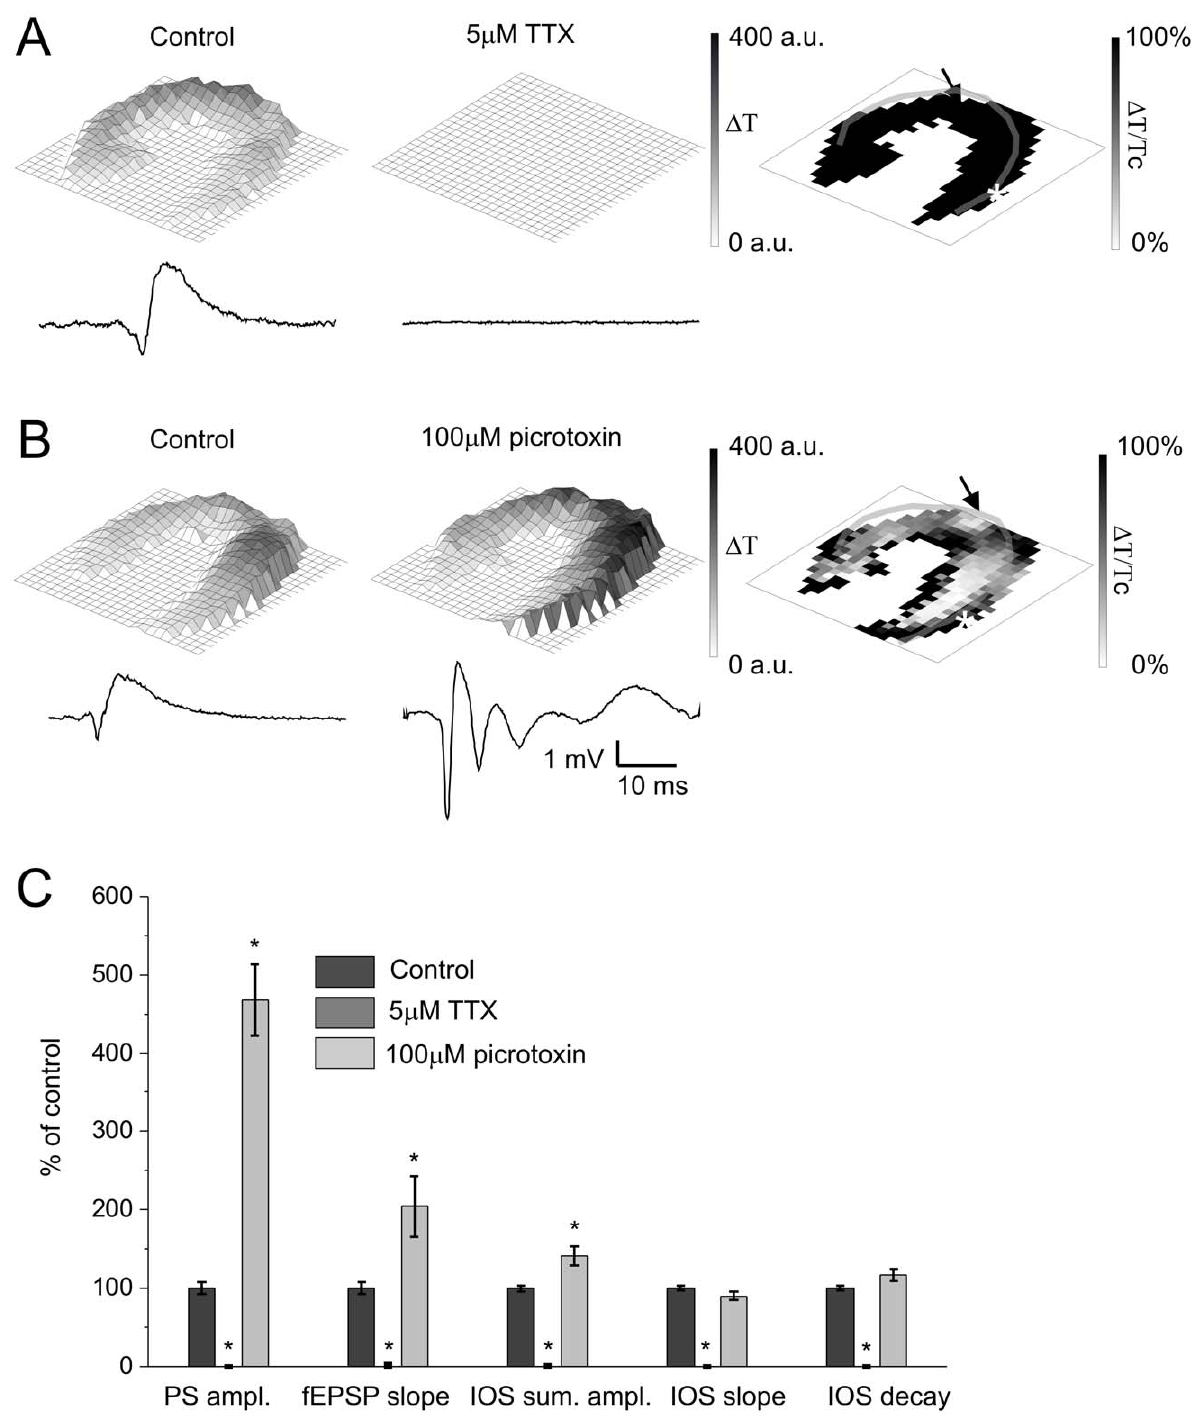
Figure 3. IOS amplitude is directly dependent on neural activity. A Left and Middle: Representative IOS amplitude map and field response curve under control condition and 5 m M TTX application. The colorbar indicates the maximum change of the transmittance compared to the resting light intensity. A Right: Spatial visualization of the percentage of control changes of IOS signal caused by TTX application. B Left and Middle: Representative IOS amplitude map and field response curve under control condition and 100 m M picrotoxin application, respectively. The colorbar indicates the maximum change of the transmittance compared to the resting light intensity. B Right: Spatial visualization of the percentage of control changes of IOS signal caused by 100 m M picrotoxin application. C: The effect of 100 m M picrotoxin and 5 m M TTX on the field response and IOS parameters in percentage of control. Asterisks indicate significant changes compared to control (P , 0.05 Mann-Whitney U test, N=5). Transparent lines on panel A, B right indicate the pyramidal cell layer. The position of the stimulating and recording electrode are marked by an arrow and asteriks, respectively.